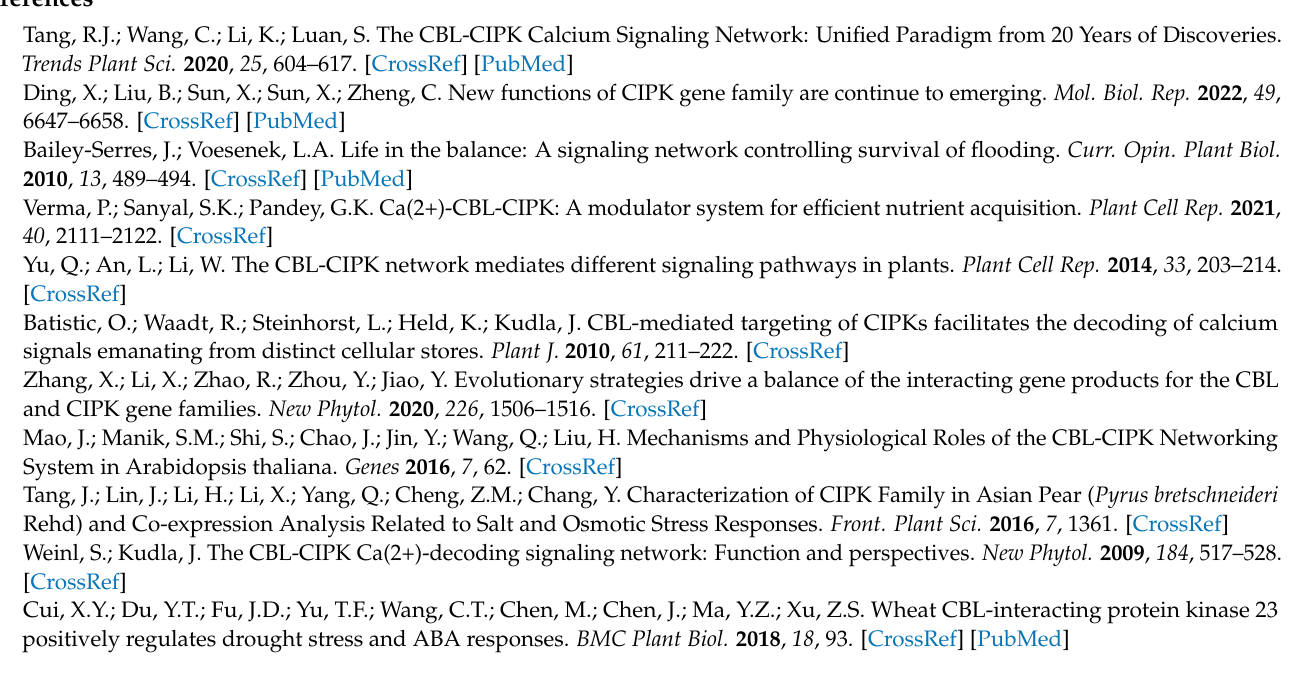
Figure S2. Comparison of PprCIPK15 CDS sequences in reference genomes and LXH; Figure S3. Comparison of PprCBL4 CDS sequences in reference genomes and LXH; Figure S4. Comparison of PprCBL5 CDS sequences in reference genomes and